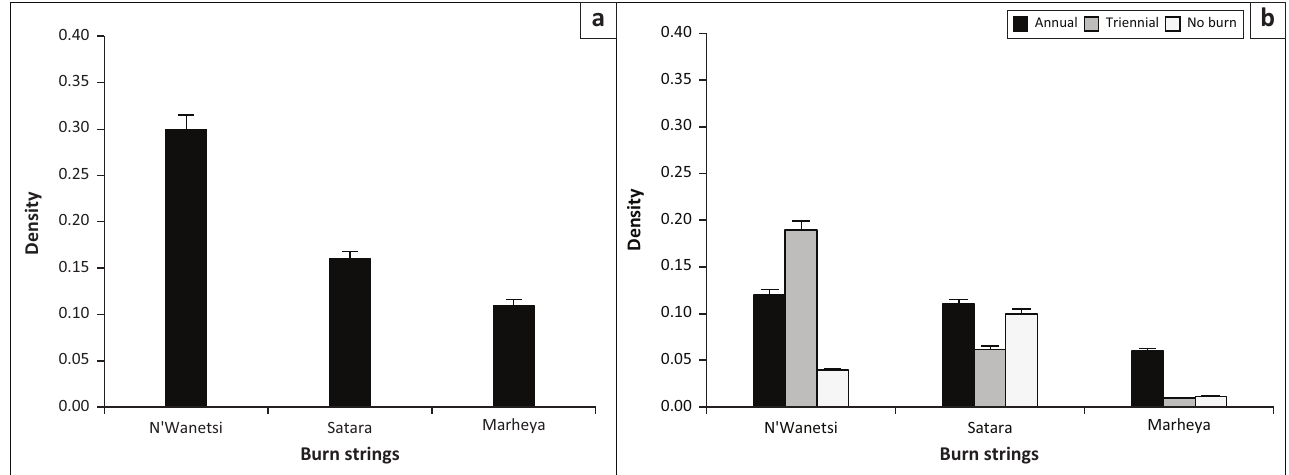
0.000.501.001.502.002.503.00 EBPs, experimental burn plots; KNP, Kruger National Park. FIGURE 3: Overall herbivore density estimates compared (a) between experimental burn plot strings and non-manipulated control areas, and (b) amongst burn strings, central Kruger National Park and the Satara management section (95 % confidence interval shown).